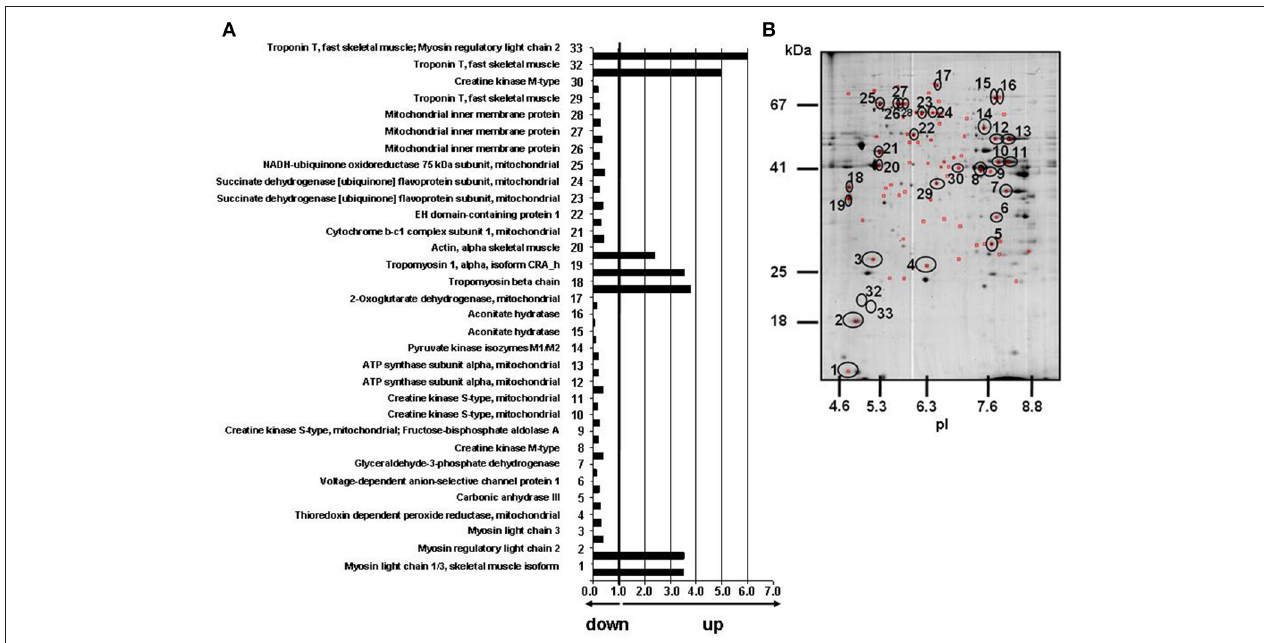
FIGURE 1 | Effects of T2-treatment on gastrocnemius muscle mitochondrial proteome. (A) Histogram of protein abundance ratio HFD + T2 vs. HFD. (B) Gastrocnemius muscle mitochondria protein profiling by 2D-E. The 32 circled and numbered spots showing differential representation after T2-treatment (vs. HFD) [at least a 2-fold variation in pairwise comparison of corresponding volumes and a statistical significance of at least 95% ( P < 0.05)], were identified by mass spectrometry analysis. 2D-E was performed using a non-linear pH range of 3–10 in the first dimension (17cm strips) and SDS-PAGE (12% T) in the second. Protein loading was 650 µ g, and the gels were stained using colloidal Coomassie